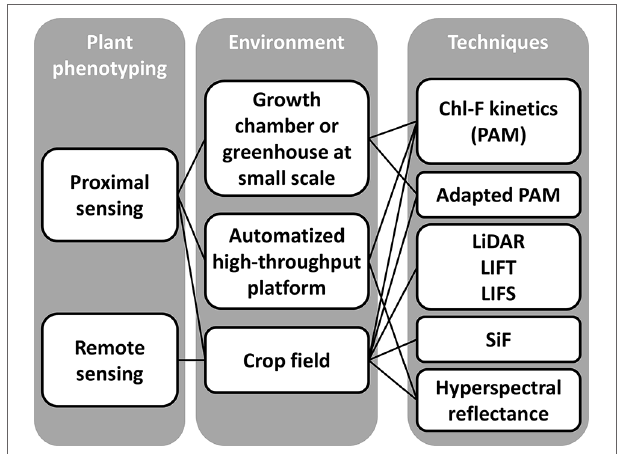
FIGURE 4 | Different approaches based on chlorophyll fluorescence imaging systems to plant phenotyping. The scales of analysis include: lab scale, high- throughput platforms under controlled environmental conditions, and filed scale under natural environmental conditions. Techniques are grouped by the source of light used for the measurements: LEDs (PAM measurements), laser (LiDAR, LIFT, and LIFS), and natural light (SiF and hyperspectral reflectance on canopy